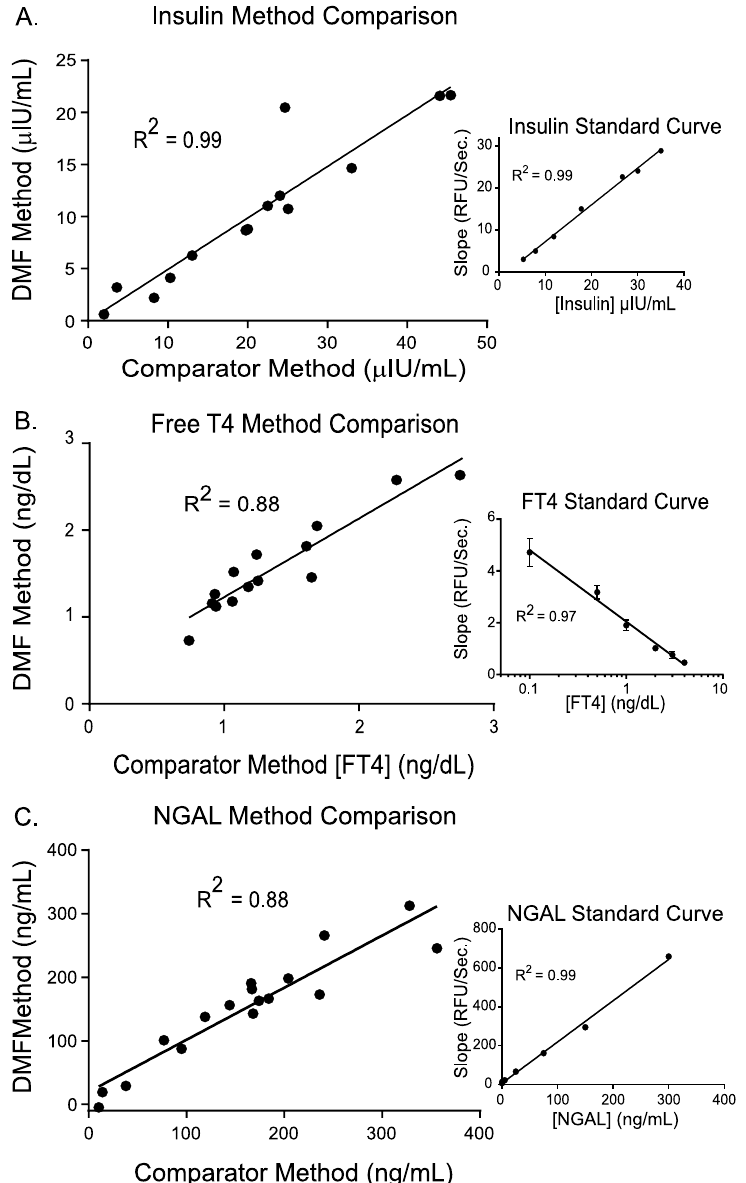
Figure 6. Immunoassay results for insulin ( A ), free T4 ( B ) and neutrophil gelatinase-associated lipocalin (NGAL) ( C ) on the DMF cartridge. ( A , B ) are sandwich and competitive immunoassays, respectively, using plasma calibrant samples; ( C ) is a sandwich immunoassay using urine calibrant samples.